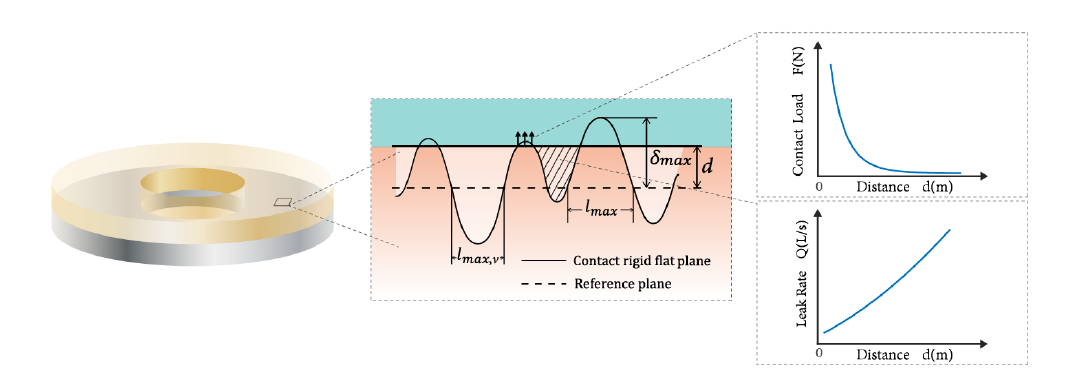
Figure 1. Schematic of the ring gasket leak rate prediction